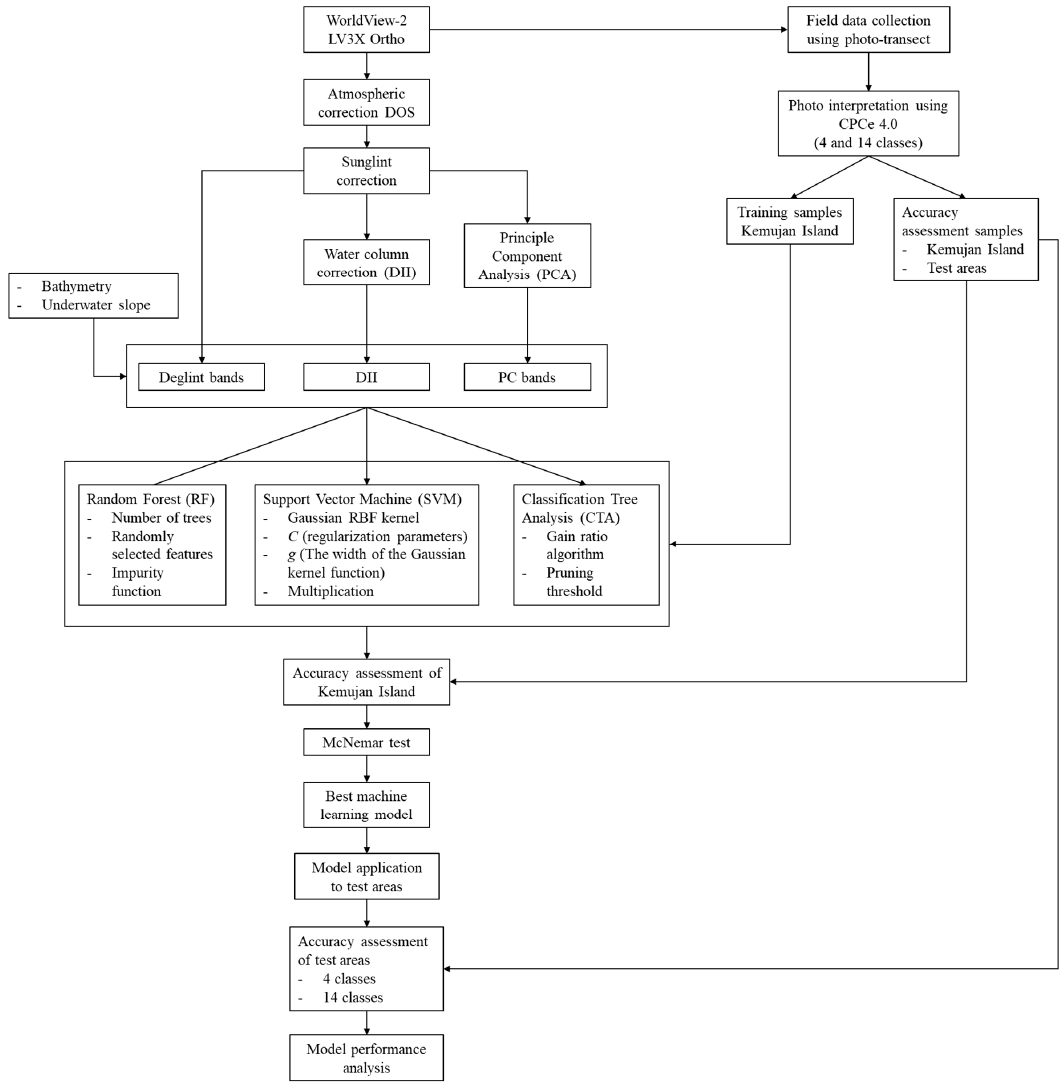
Figure 3. Research flowchart for benthic habitat mapping model and cross validation using machine- learning classification